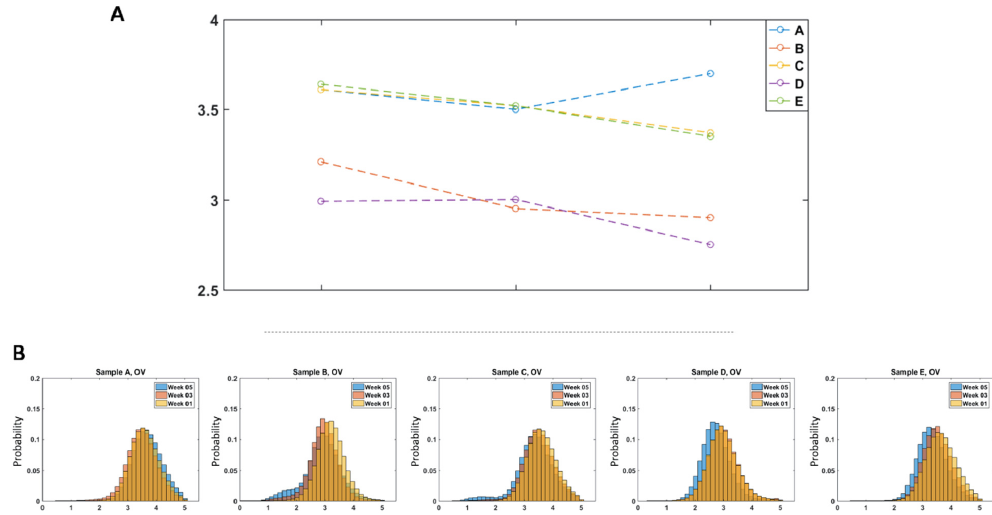
Figure 5. ( A ) Line plots of optical volume for all samples over the storage time ( B ) Normalized histogram of optical volume of cells over the storage period for Sample A–E. As can be seen in the line plots, the optical volume consistently decreased over the storage time for all samples except Sample A, which declined at week 3, but paradoxically rose at the week 5 time point. The change in the parameter over the storage period is also illustrated using the normalized histograms in Figure 5B where the optical volume of the cells decreased over the storage period for Samples B–E. Similarly, the area of the cells follows the trend as shown by the mean value of this parameter with line plots in Figure 6A. Figure 6. ( A ) Line plots of area for all samples over the storage time, ( B ) Normalized histogram of area of cells over the storage period for Sample A–E.